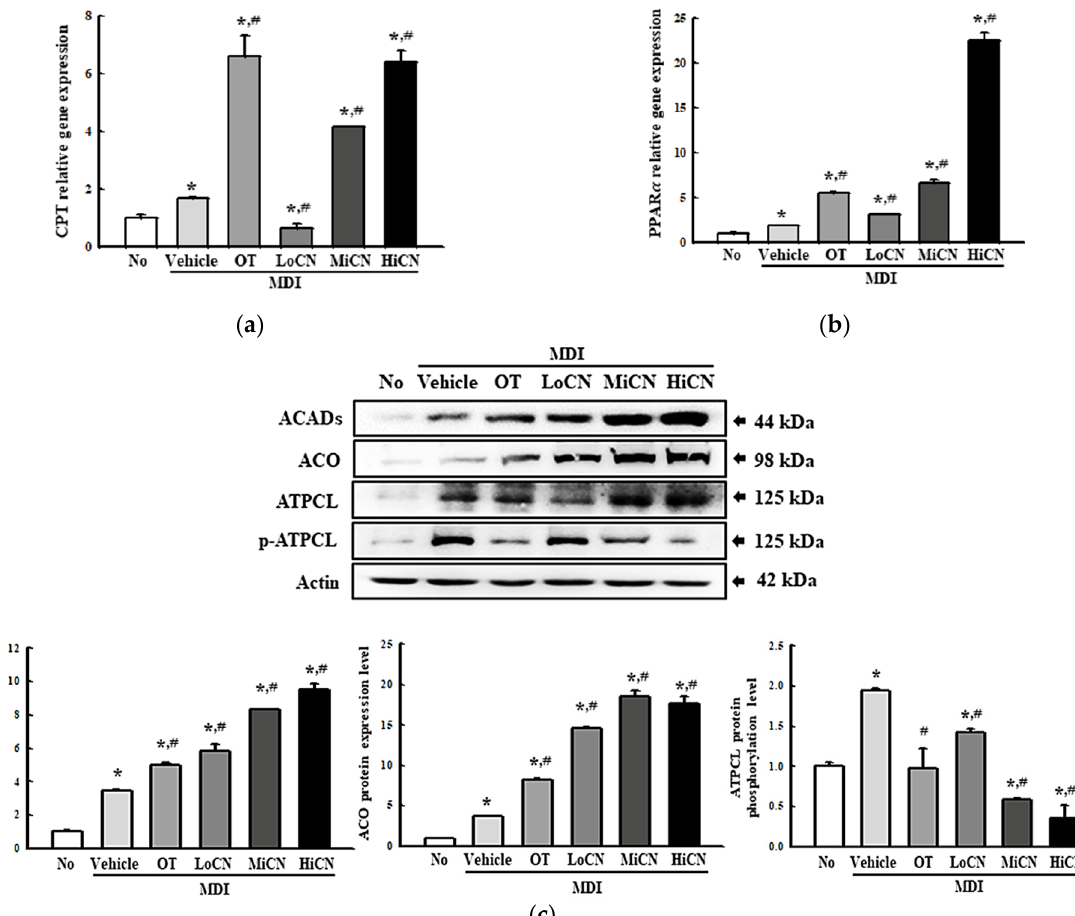
Figure 8. mRNA levels and protein expression of the β -oxidation relative factors. ( a , b ) mRNA levels of the β -oxidation relative factors. After collecting the total RNA from MDI stimulated 3T3-L1 adipocytes treated with α -cubebenol, the mRNA levels of CPT ( a ) and PPAR α ( b ) gene for β -oxidation were measured by RT-qPCR, as described in Materials and Methods. Two to three dishes per group were used to prepare the total RNAs, and qRT-PCR were assayed in duplicate for each sample. ( c ) Expression level of β -oxidation relative proteins. After collecting the total proteins from the MDI-stimulated 3T3-L1 adipocytes treated with α -cubebenol, the expression level of ACADS, ACO, ATPCL, p -ATPCL, and β -actin were detected using the specific primary antibodies, followed by horseradish peroxidase (HRP)-conjugated goat anti-rabbit IgG. The intensity of each band was measured by an imaging densitometer, and the relative levels of each protein were calculated relative to the intensity of the actin bands. Two to three dishes per group were used to prepare the cell homogenates, and Western blot analysis was assayed in duplicate for each sample. The data represent the means ± SD of three replicates. * indicates p < 0.05 compared to the No treated group. # indicates p < 0.05 compared to the MDI + Vehicle treated group. OT, orlistat; MDI, adipogenic cocktail consisting of 3-isobutyl-1-methylxanthine, dexamethasone, and insulin; LoCN, low concentration (7.5 μ g/mL) of α -cubebenol; MiCN, middle concentration (15 μ g/mL) of α -cubebenol; HiCN, high concentration (30 μ g/mL) of α -cubebenol.